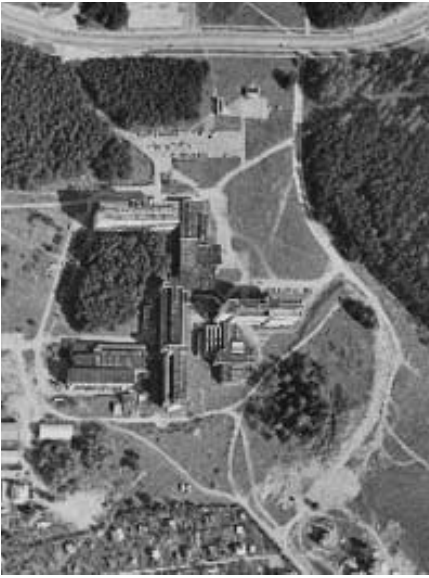
Fig 4. Fragment of generated